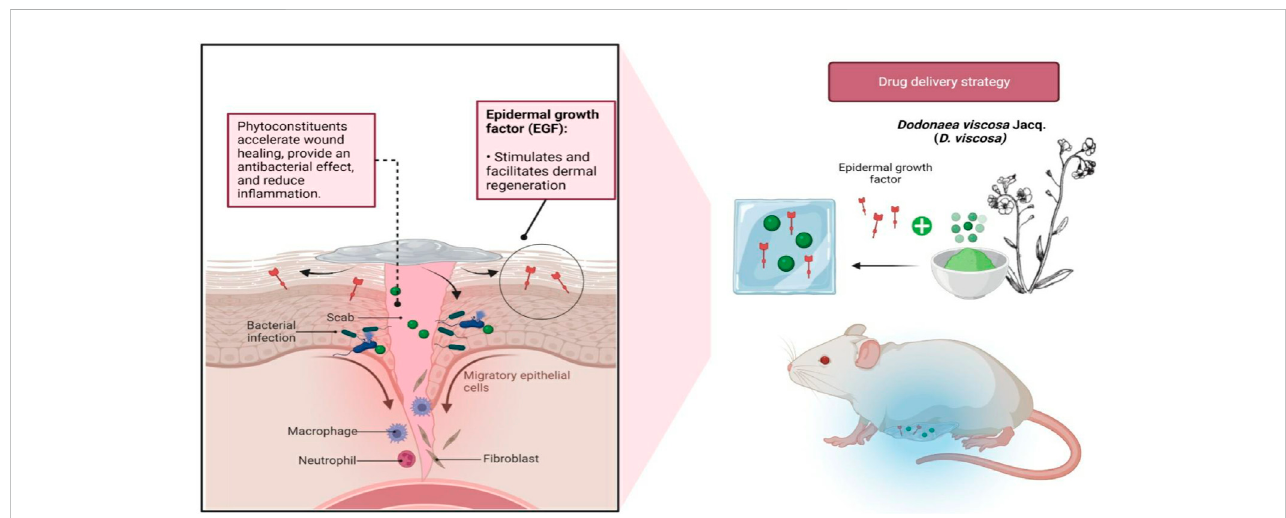
FIGURE 10 Future perspectives of encapsulating D. viscosa phytoconstituents into hydrogels with epidermal growth factor (EGF) against infected wounds. The fl avonoids found in the plant may expedite healing and the eradication of bacteria, whereas the presence of EGF will facilitate in dermal